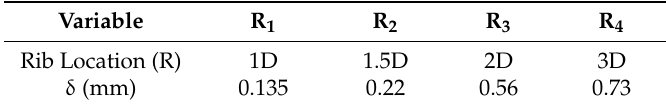
Table 2. Velocity boundary layer thickness at different rib locations [25].